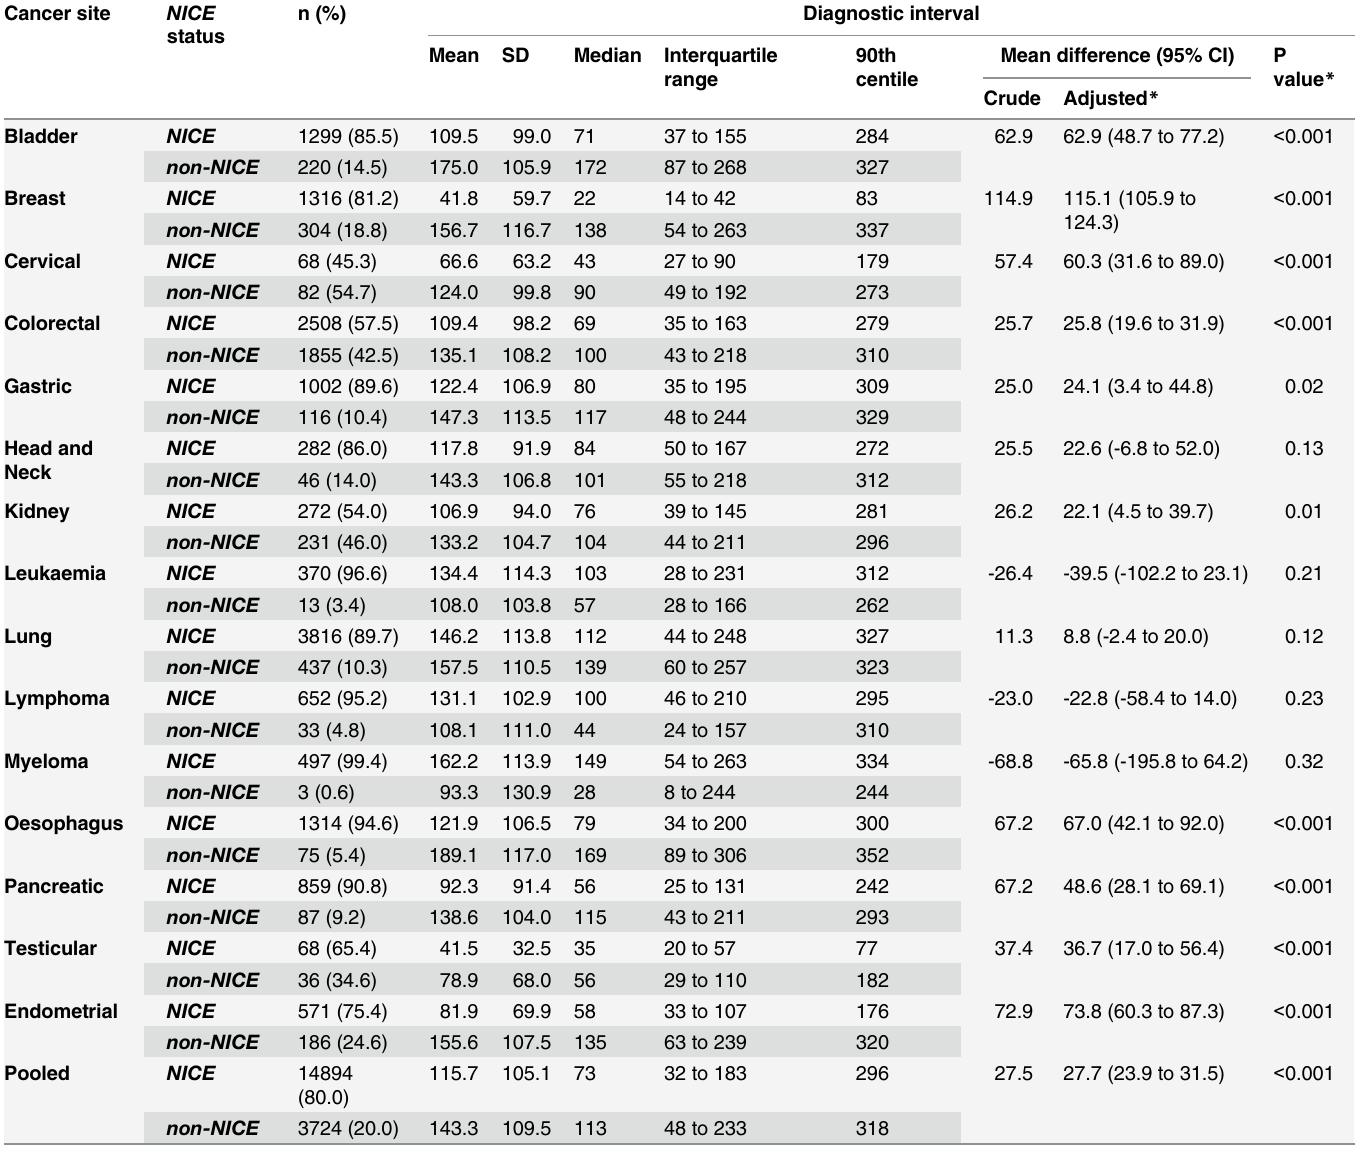
Table 5. Regression analysis of diagnostic intervals by NICE status in 15